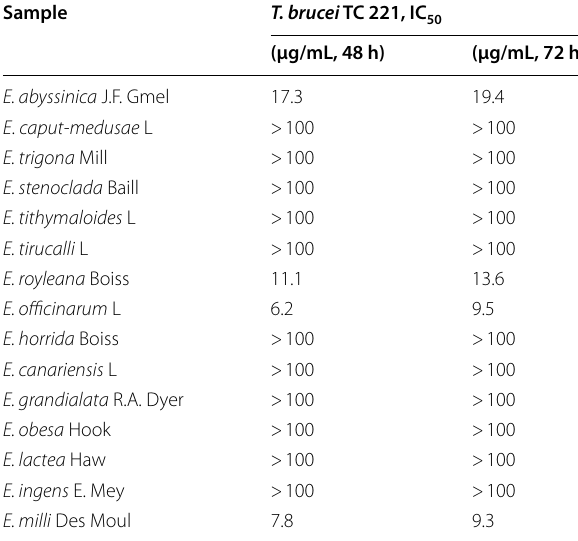
Table 1 IC μg/mL values of methanolic Euphorbia extracts 50 after 48‑h and 72‑h